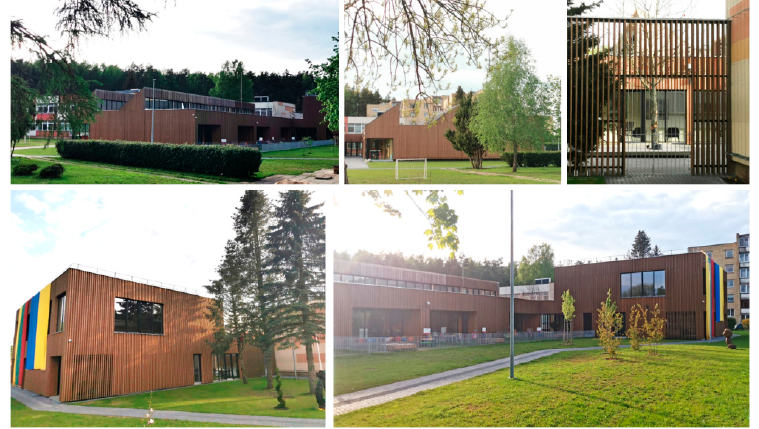
Figure 2. Kindergarten “Peledziukas” located in Vilnius, made with materials and roof configuration recalling traditional wood architecture was selected as an example of mimetic biophilic design. Photographs by A. Daugelaite. Example B—Vilnius University Kairenai Botanical Garden’s Green Building-Plant